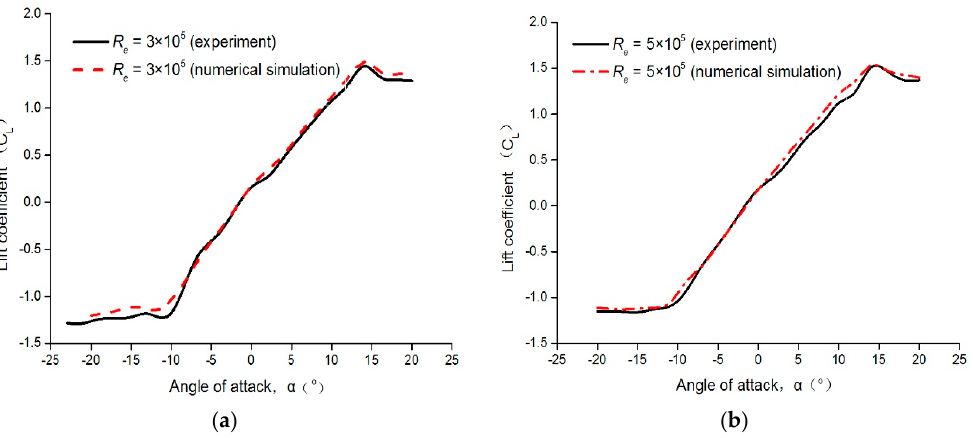
Figure 9. Lift coefficient for the LUT airfoil at different values of R e : ( a ) the case of R e = 3 × 10 5 ; and ( b ) the case of R e = 5 × 10 5 . The lines in black and red of the lift coefficient correspond to the experimental results and the numerical simulation results, respectively.